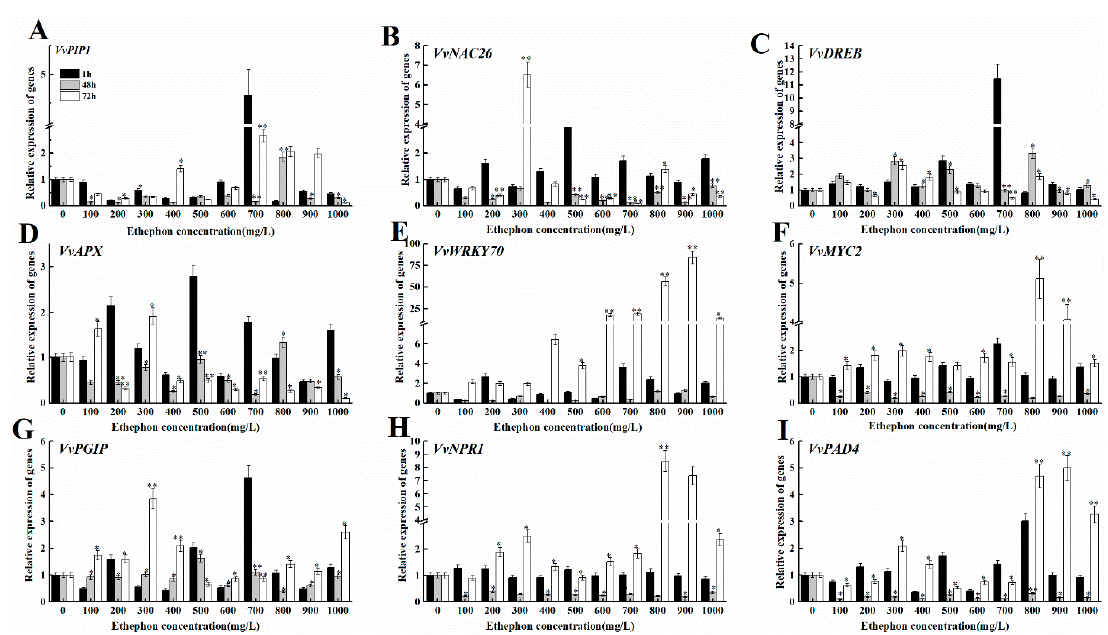
Figure 11. Effects of different concentrations of ethephon treatment on genes expression of disease resistance in mature grape fruit. Different concentration of ethephon (100, 200, 300, 400, 500, 600, 700, 800, 900, and 1000 mg/L) were sprayed on the fruit surface for 24 h, and then B. cinerea was inoculated on the grape. Samples were collected at 1, 48, and 72 h after botrytis infection and the transcript levels of disease resistant genes including ( A ) VvPIP1 , ( B ) VvNAC26 , ( C ) VvDREB , ( D ) VvAPX , ( E ) VvWRKY70 , ( F ) VvMYC2 , ( G ) Vvpgip , ( H ) VvNPR1 , and ( I ) VvPAD4 . Values are means ± SD of five biological replicates. * and ** Significant differences compared with the control (water-treated fruits) sample at p < 0.05 and p < 0.01, respectively using Student’s test.